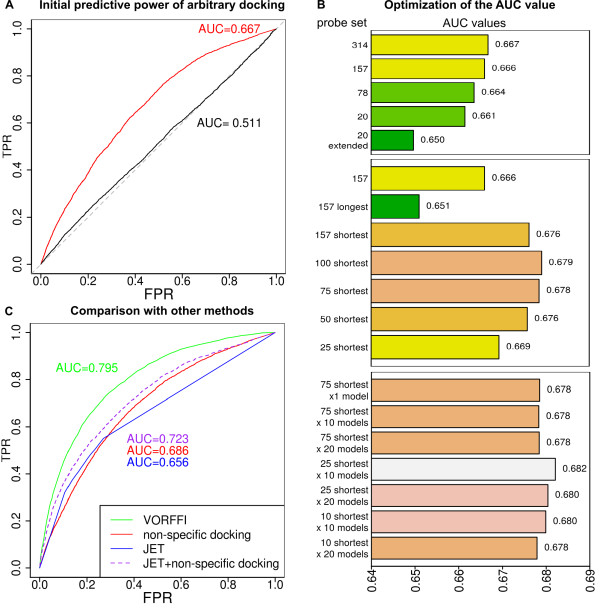
Arbitrary docking has the power to predict native interfaces.A: Initial ROC curves obtained for all exposed residues in the target set of 198 proteins. In red, the number of docking hits after docking with the 314 compact probes is used as a predictor. In black, for comparison, the ROC curve obtained using hits generated with the random model shown in Figure 1B. The number of hits per exposed residue is normalized for each protein as described in the Method section. B: Optimization of the number and size of the probes, and the number of docking models per probe, to increase the AUC value. Top: varying the number of probes. Middle: varying the size of the compact probes. Bottom: varying the number of docking solutions. Bars with the same color correspond to AUC values that are statistically indistinguishable (p-val > 5%). C: Comparison with other methods, considering predictions obtained by arbitrary docking with the 25 shortest probes and the first 10 docking models. The combination of arbitrary docking hits with JET is detailed in the text.